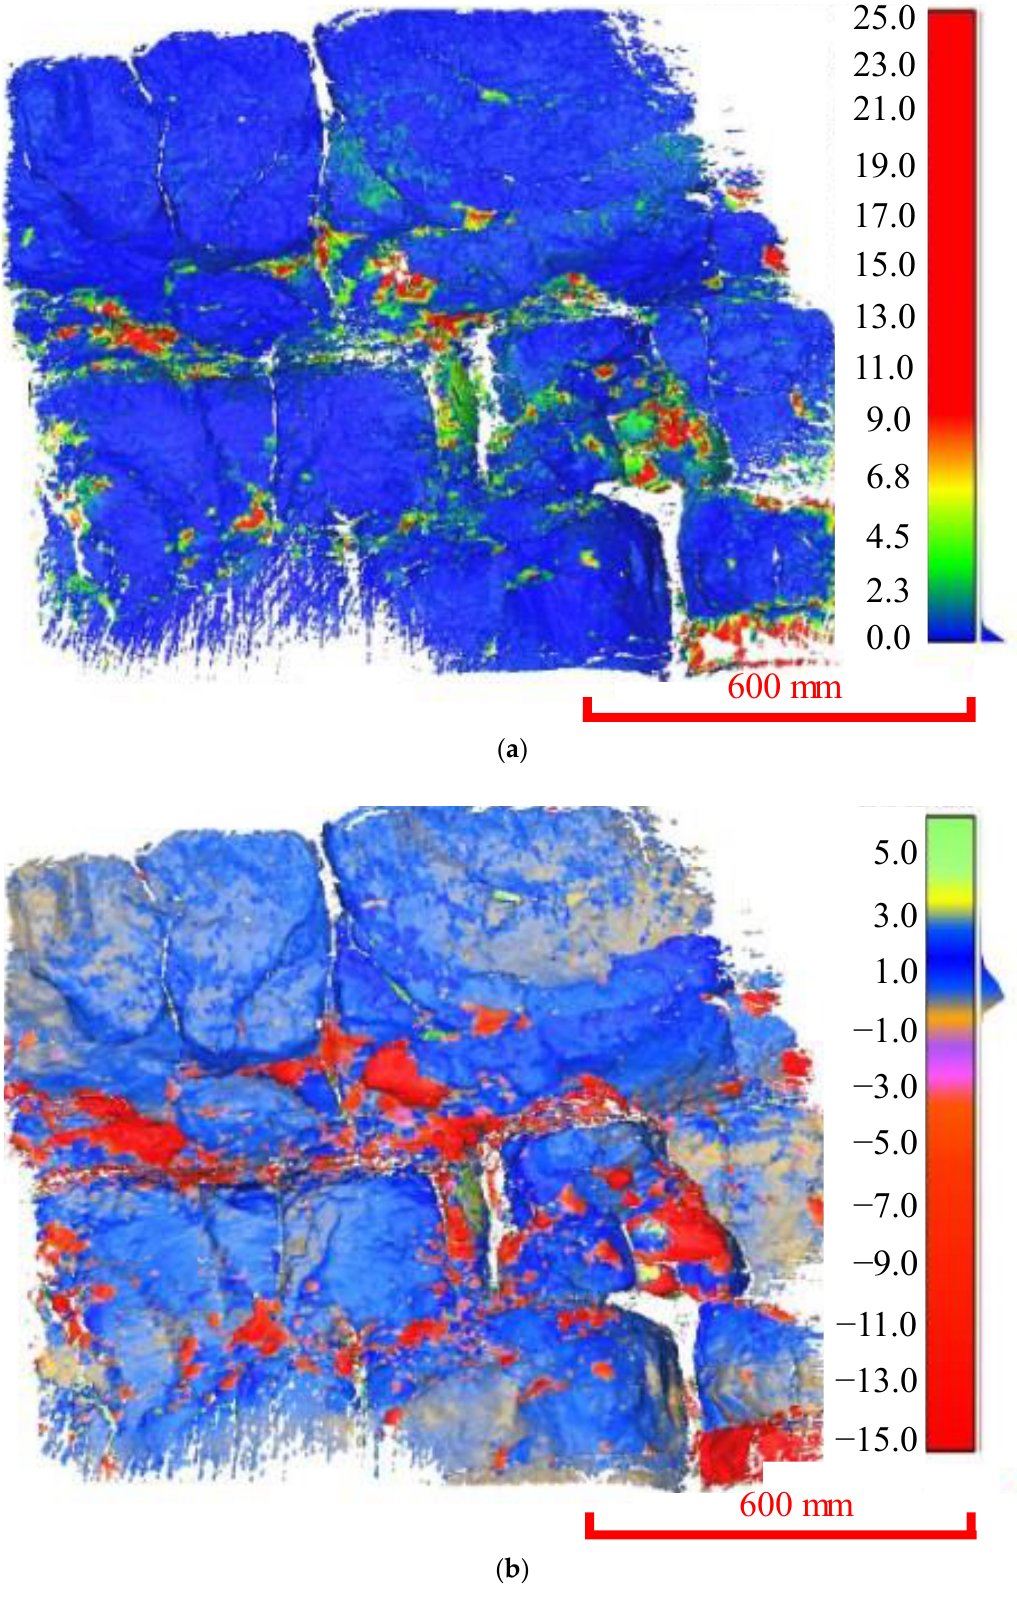
Figure 9. The 3D cloud diagrams of the measured area (2 m × 2 m). ( a ) Deformation distribution obtained using the C2C method. ( b ) Deformation distribution obtained using the M3C2 method.